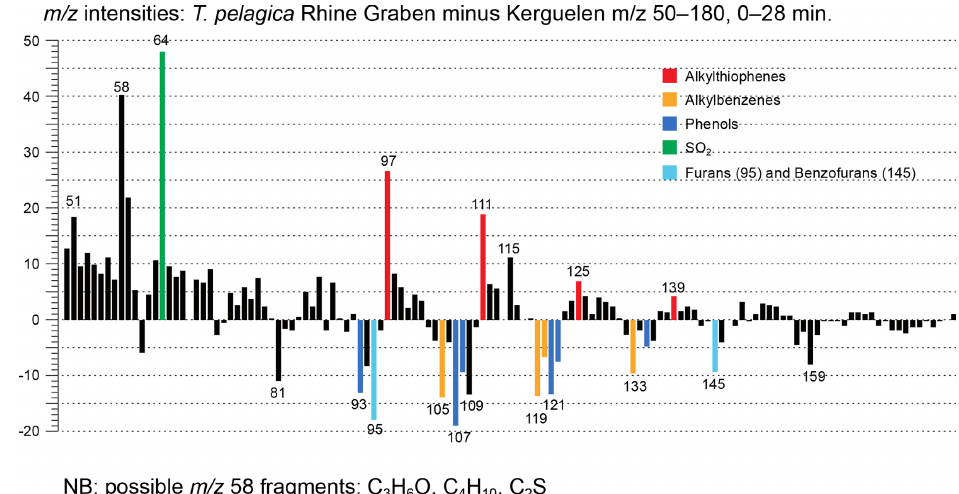
Figure 8. Relative mass intensities of the total chromatograms of Thalassiphora pelagica from the Rhine Graben minus those of Thalas- siphora pelagica from the Kerguelen Plateau (Versteegh et al., 2007). Masses with abundances < 0 are more abundant in the specimens from the Kerguelen Plateau. Note the masses indicating sulfur-containing fragments (thiophenes) are more important in the specimens from the Rhine Graben, whereas masses characterizing oxygen-containing fragments (furans, phenols) and alkylbenzenes are more abundant in specimens from the Kerguelen